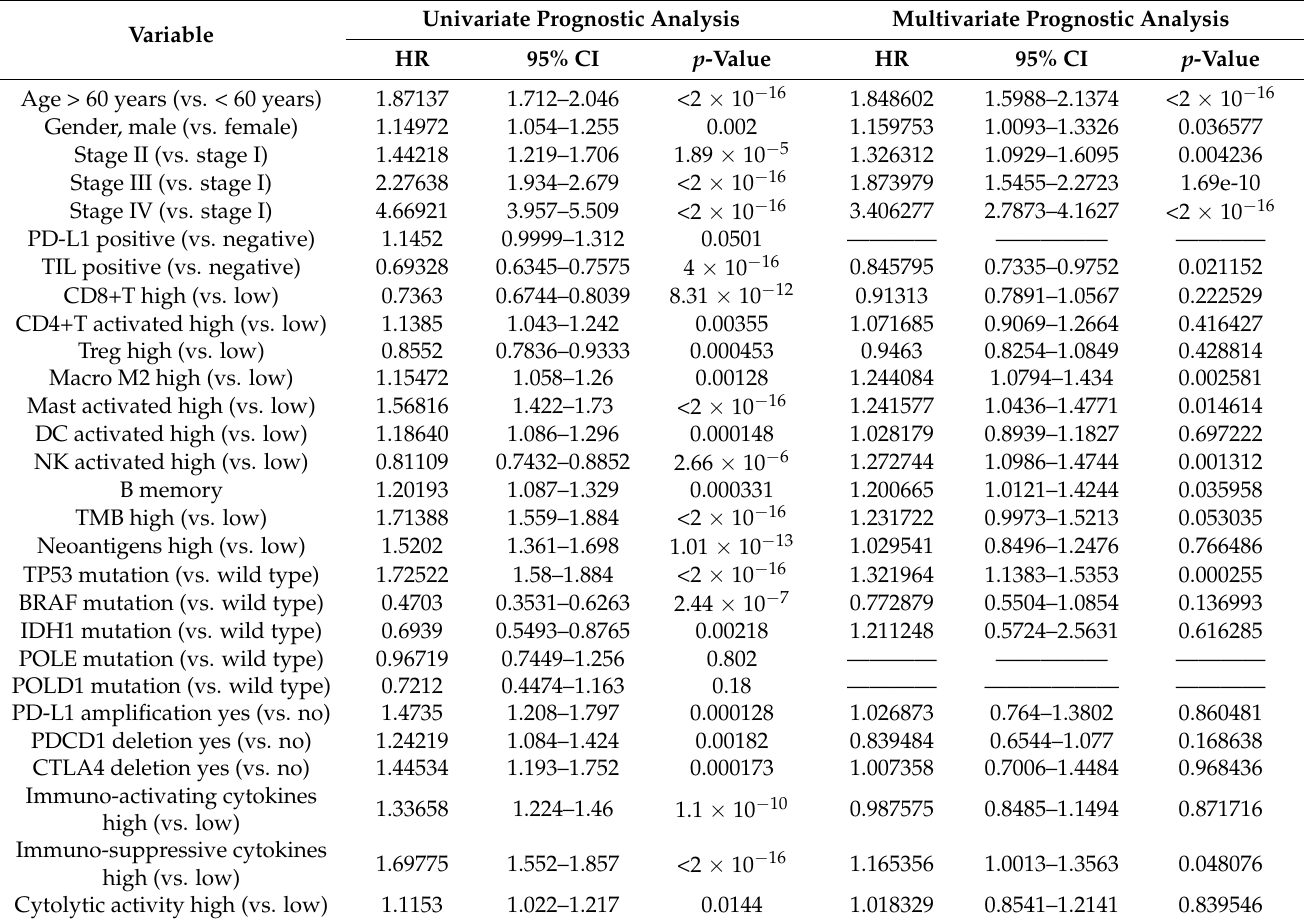
Table 3. Univariate and multivariate cox proportional hazards analysis for overall survival in pan-cancer